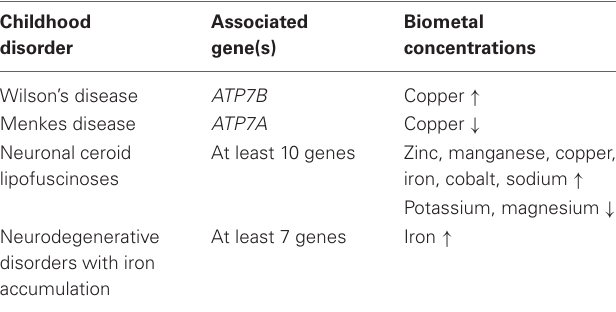
Table 1 | Biometal alterations in childhood